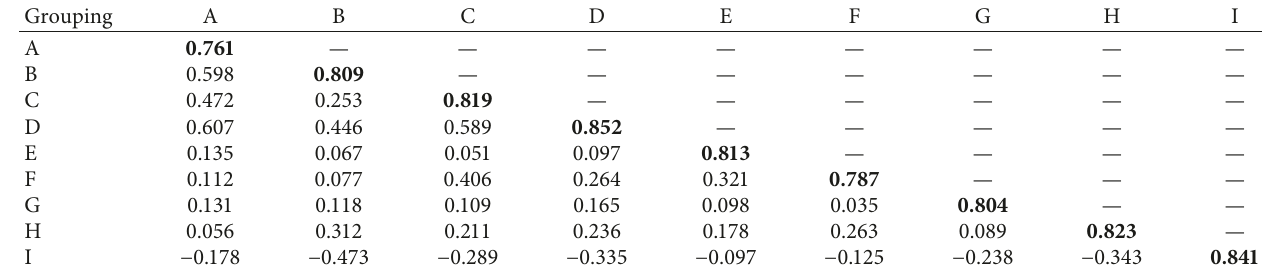
Table 4: Discriminant validity of the nine groups.